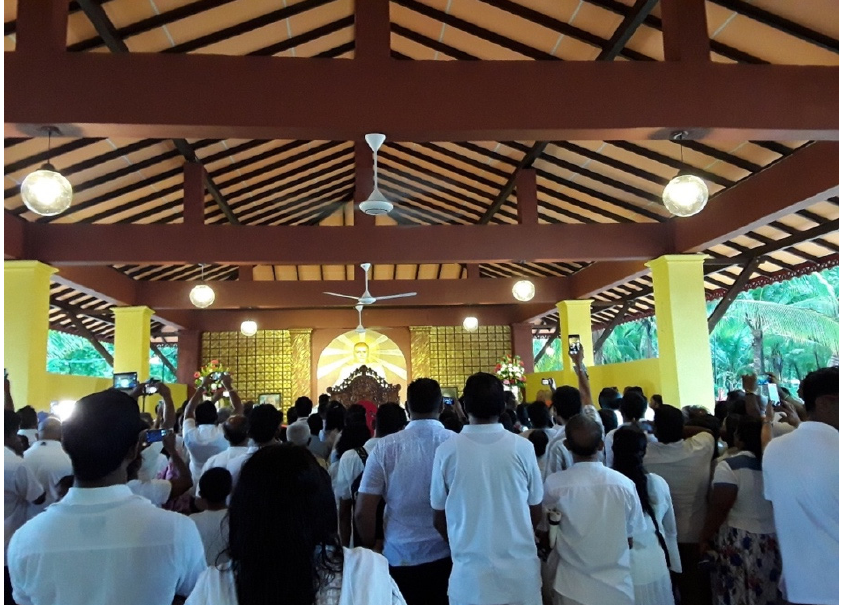
Figure 3. People gathered for the dhamma sermon in the preaching hall in front of the Samantha- bhadra’s statue. Photo by author. 19 October 2019, Umandawa Monastery, Kurunegala.